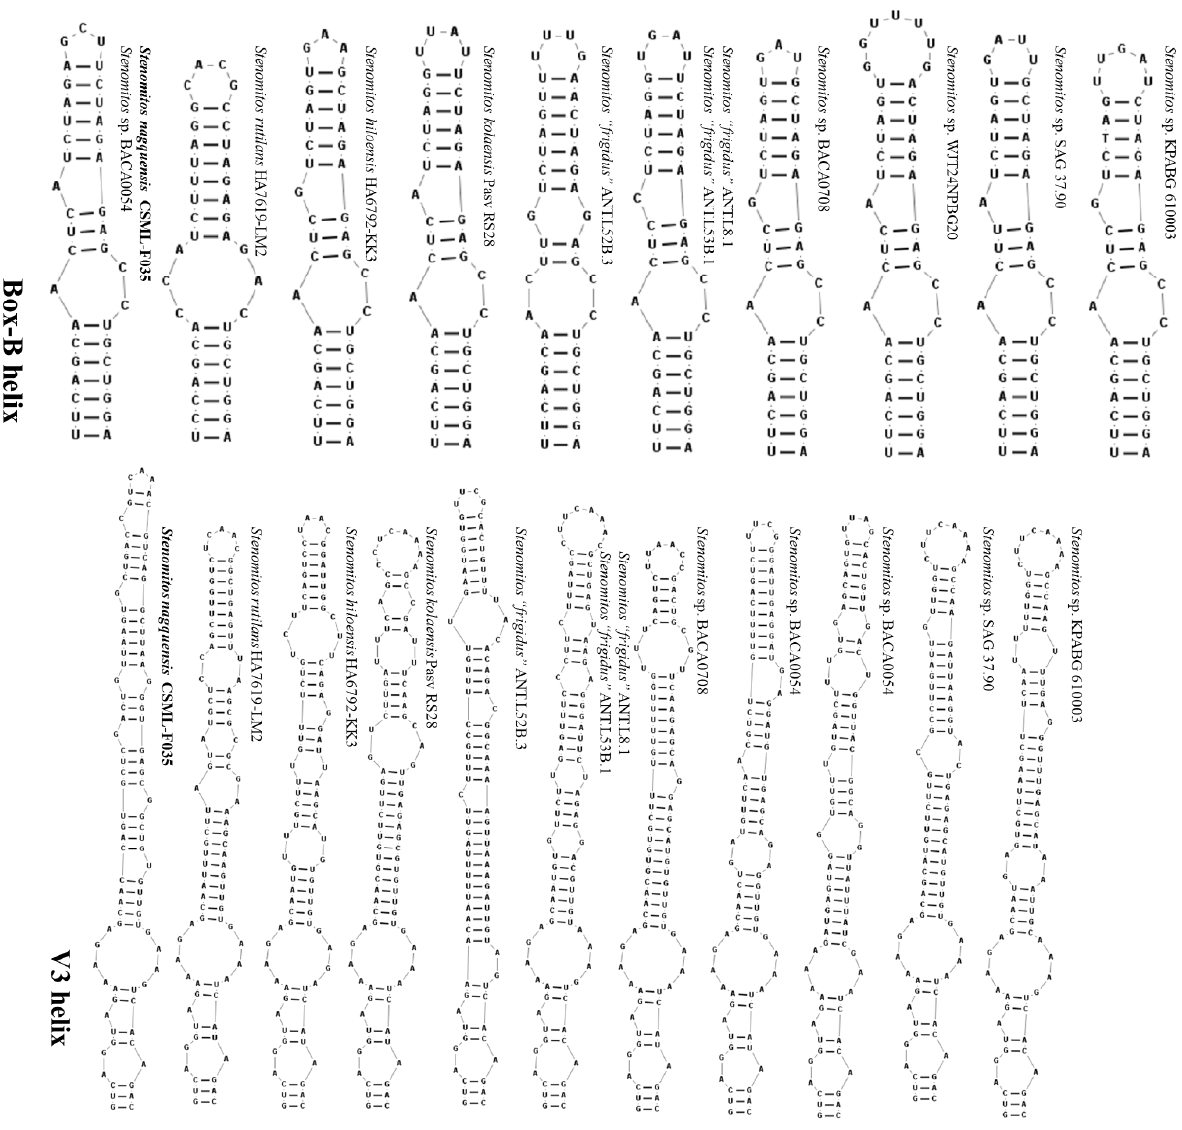
Figure 7. Predicted secondary structures of Box-B and V3 helices of the 16S–23S ITS region of strains of Stenomitos . The novel species is labelled in